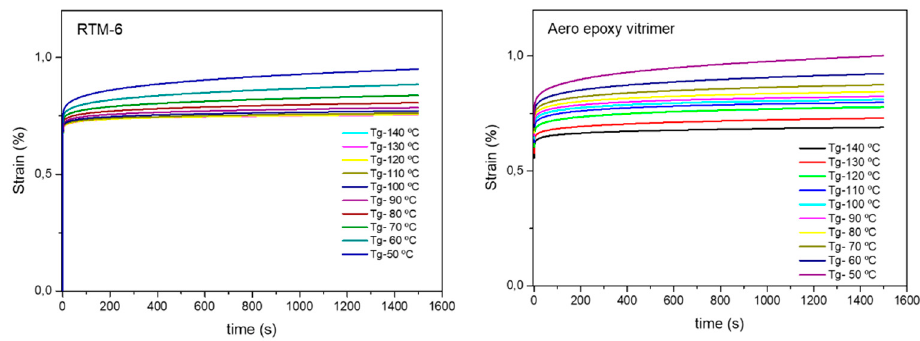
Figure 7. Creep experiments of reference RTM6 and aero grade epoxy vitrimer at temperatures be- low Tg (from Tg − 140 °C to Tg − 50 °C) with applied stress of 10 MPa for 25 min.